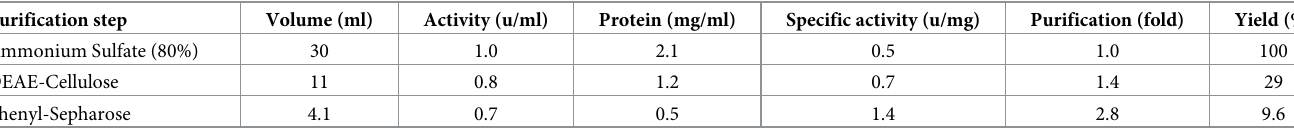
Table 2. Purification of AP56 from strain FRD1185(pSS380) Ela - Apr - PaAP +++ . Purification step